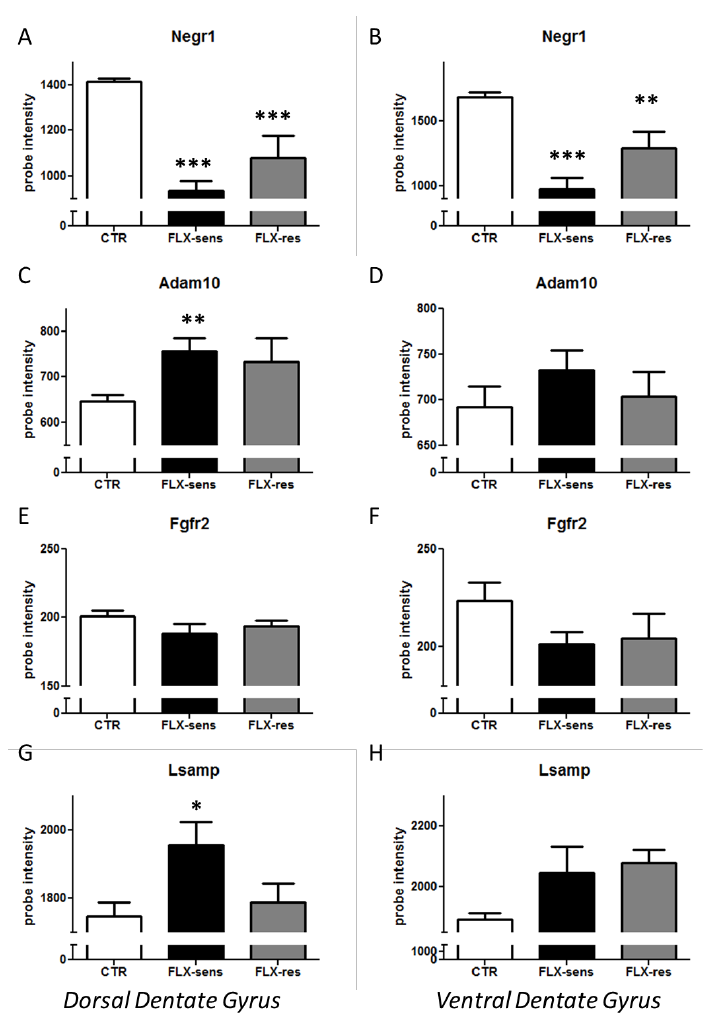
Figure 4. mRNA levels of genes belonging to the Negr1-Fgfr2 pathway in the dorsal dentate gyrus ( A , C , E , G ) or ventral dentate gyrus ( B , D , F , H ) of the hippocampus after fluoxetine or vehicle administration. Groups showing fluoxetine behavioural sensitivity or resistance are shown as black or grey columns, respectively. ( A , B ) Negr1 expression; ( C , D ) Adam10 expression; ( E , F ) Fgfr2 expression; and ( G , H ) Lsamp expression. * p < 0.05, ** p < 0.01, *** p < 0.001 in the planned comparison vs. vehicle. FLX: fluoxetine. n =